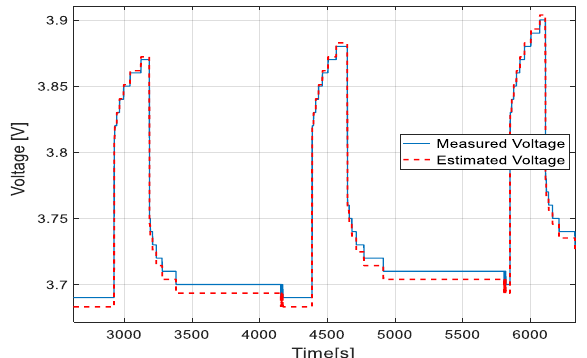
Figure A6. Zoomed image of the estimated test voltage.